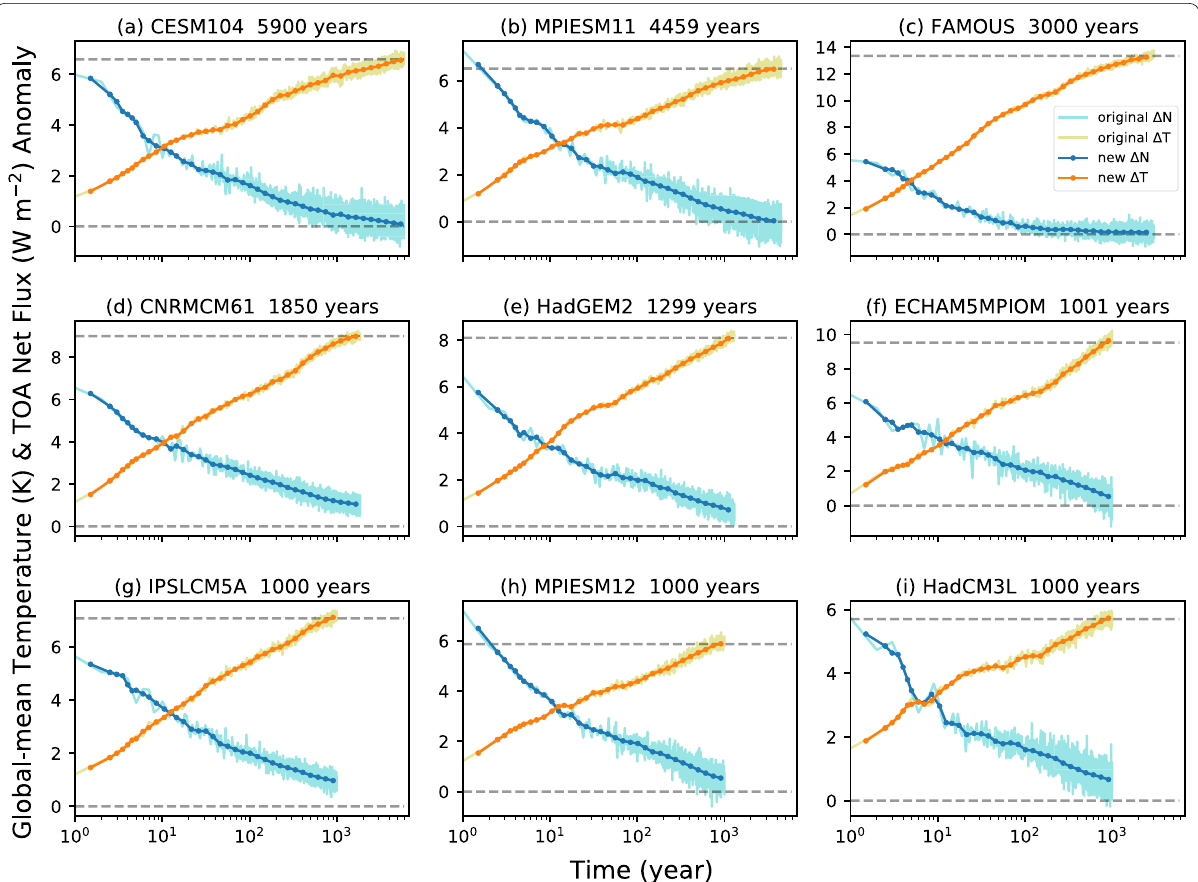
Fig. 1 Time series of the global-mean and annual-mean surface temperature anomaly (cid:31) T and TOA net radiative flux anomaly (cid:31) N in the abrupt4xCO2 (relative to piControl) experiments of LongRunMIP models. The yellow and light blue solid lines are the (cid:31) T and (cid:31) N of the original series, respectively. The orange and blue dotted lines are the (cid:31) T and (cid:31) N of the new series, respectively. The upper dashed grey line is the average (cid:31) T of the last 300 years. The lower dashed grey line marks